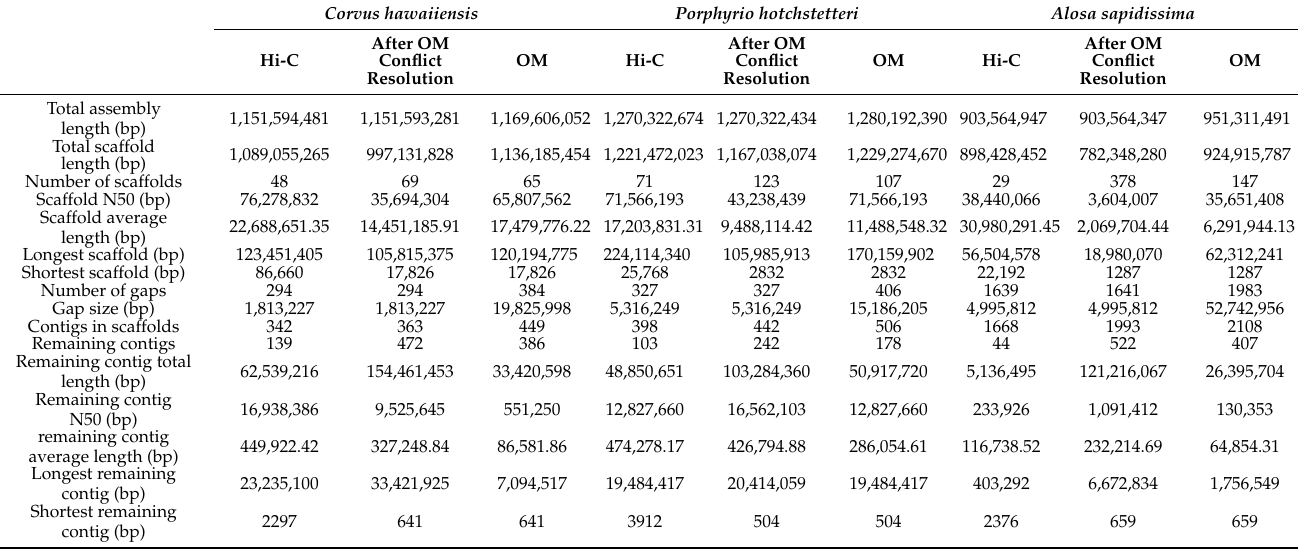
Table 5. Statistical data for the Corvus hawaiiensis, Porphyrio hotchstetteri and Alosa sapidissima scaffolded assemblies generated from PacBio data in the Vertebrate Genome Project (Hi-C), the assembly statistics after conflicts resolution (After OM conflict resolution) and the final hybrid scaffold integrating the PacBio assembly with Hi-C and optical maps scaffolding